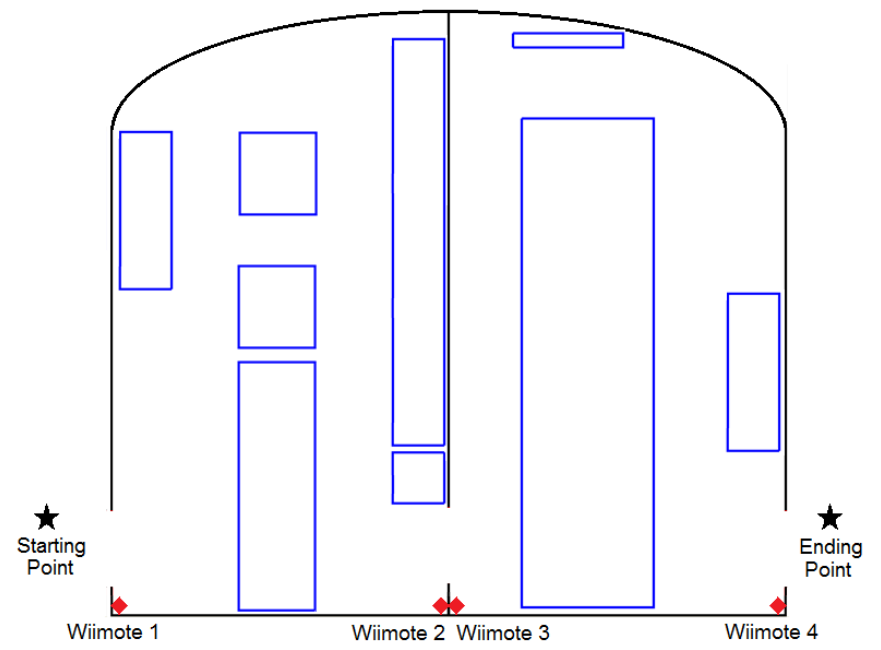
Figure 13. Distribution ―A‖ of the experimentation area.